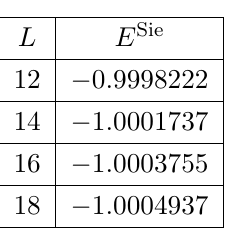
Table 8 . ( L; 3 L ) level-truncation results for the vacuum energy in Siegel gauge extracted from reference